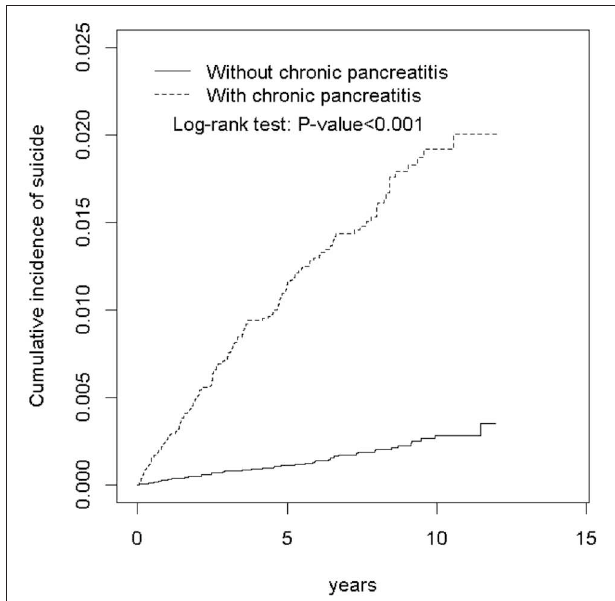
FIGURE 1 | Cumulative incidence of suicide attempt for individuals with and without chronic pancreatitis.